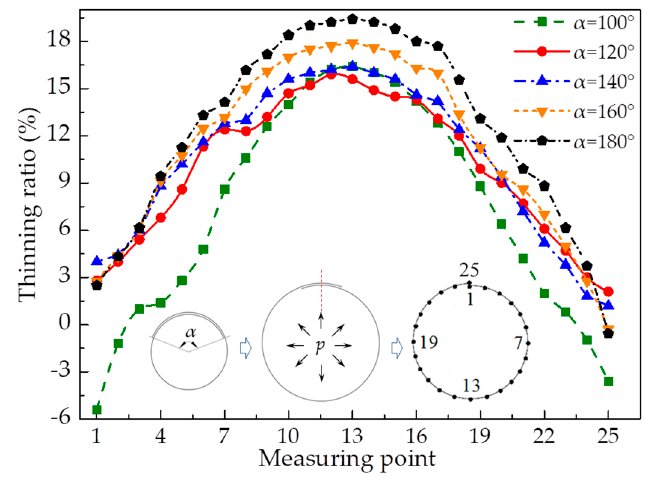
Figure 21. Effect of the overlap angle on the thickness distribution at the middle cross-section.